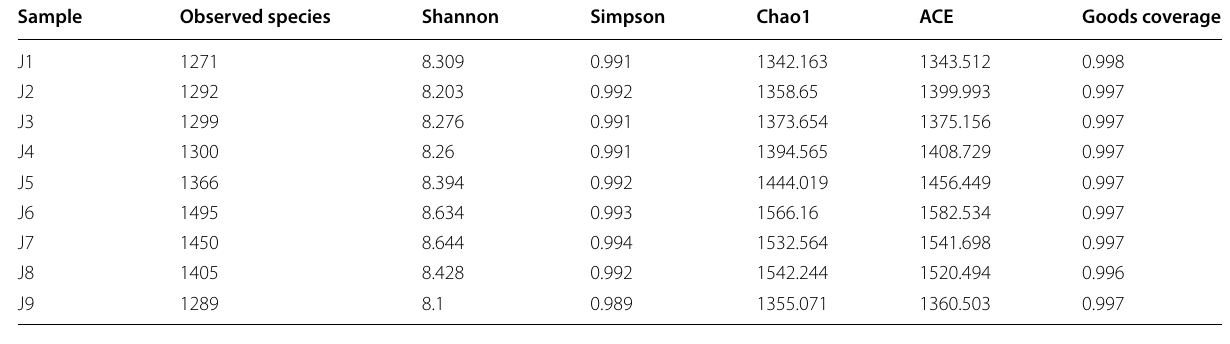
Table 2 Alpha-diversity of the gut microbiota in the nine golden takins in this study Sample